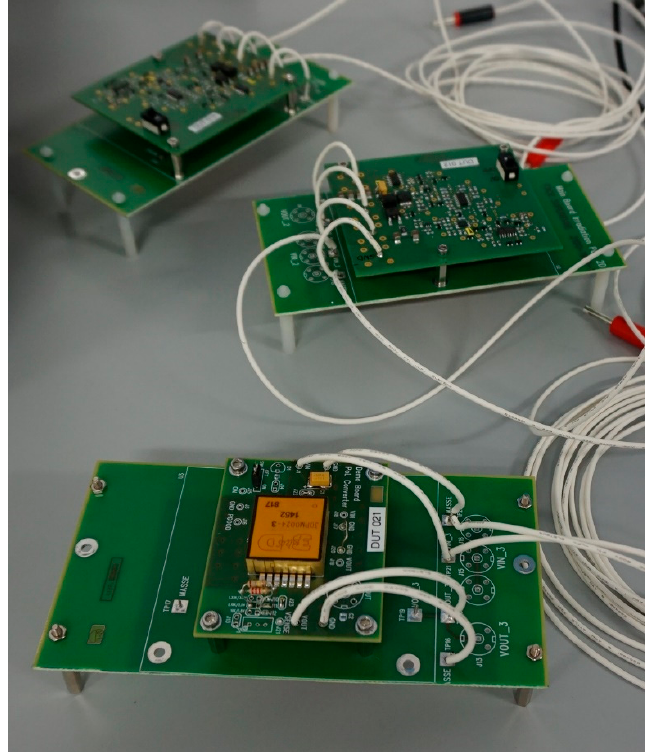
Figure 2. PoL 3D SiP on the auxiliary board and attached to the motherboard (first plan) and two PoL 2D boards on their motherboards (second plan). Table 1. TID status for active devices used in PoL module (from [14]). Results in Accordance Type